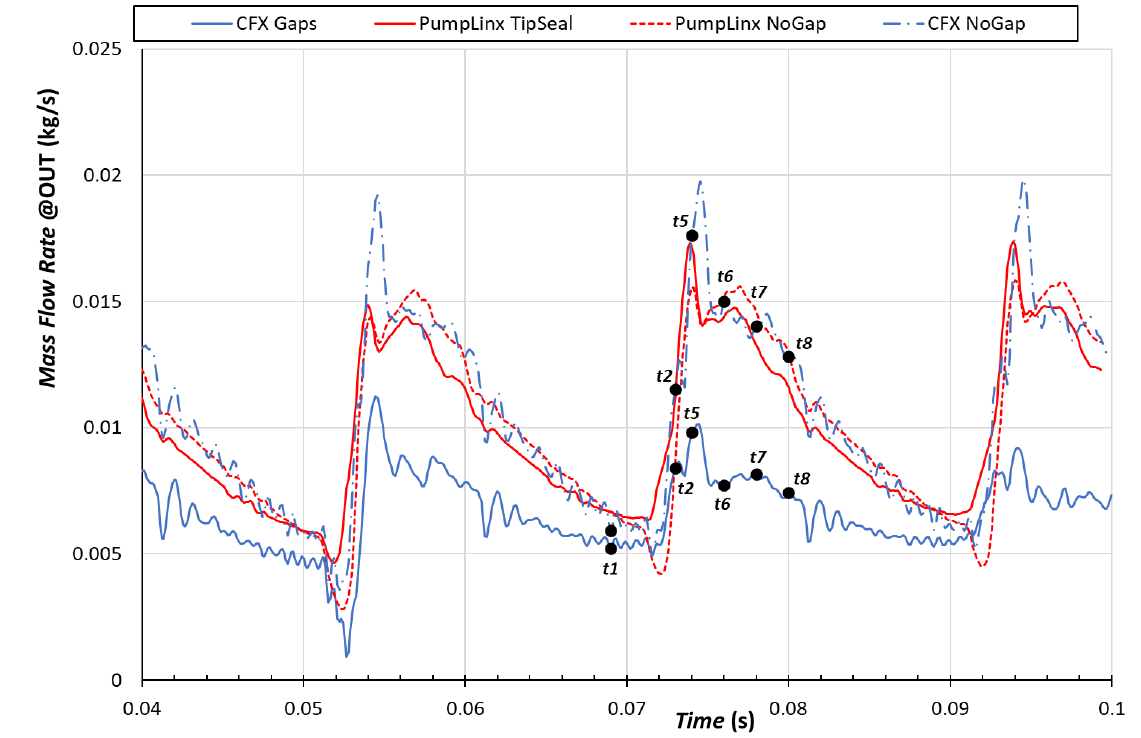
Figure 23. Evolution over time of the mass flow rate at the outlet port during the last three orbit revolutions of the rotating scroll: CFX with axial gap (blue solid line), CFX without axial gap (blue dash-dot line), PumpLinx with the perfect tip seal (red solid line), and PumpLinx without axial gap (red dash-dot line).